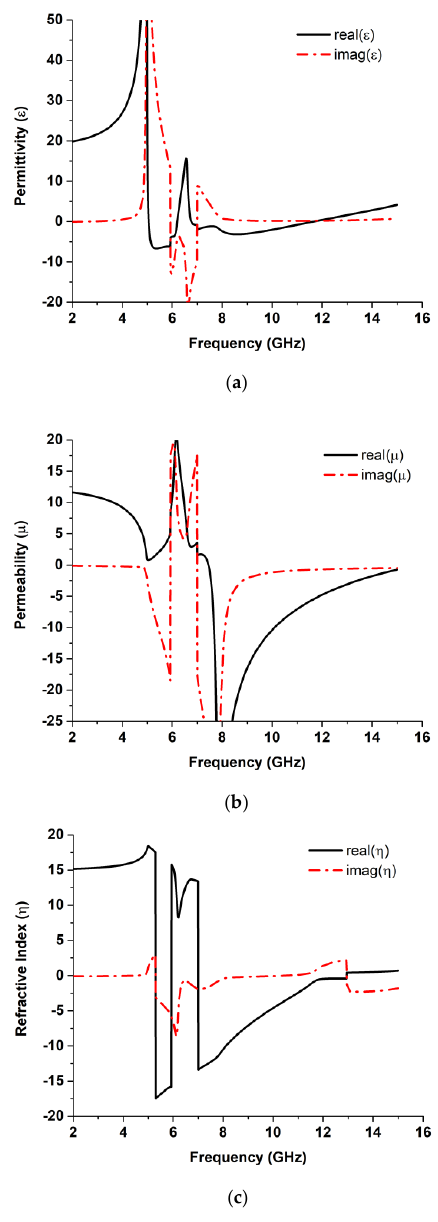
Figure 3. Effective Parameters: ( a ) permittivity, ( b ) permeability, and ( c ) refractive index. Table 2. Summary of the effective parameters of the unit cell.